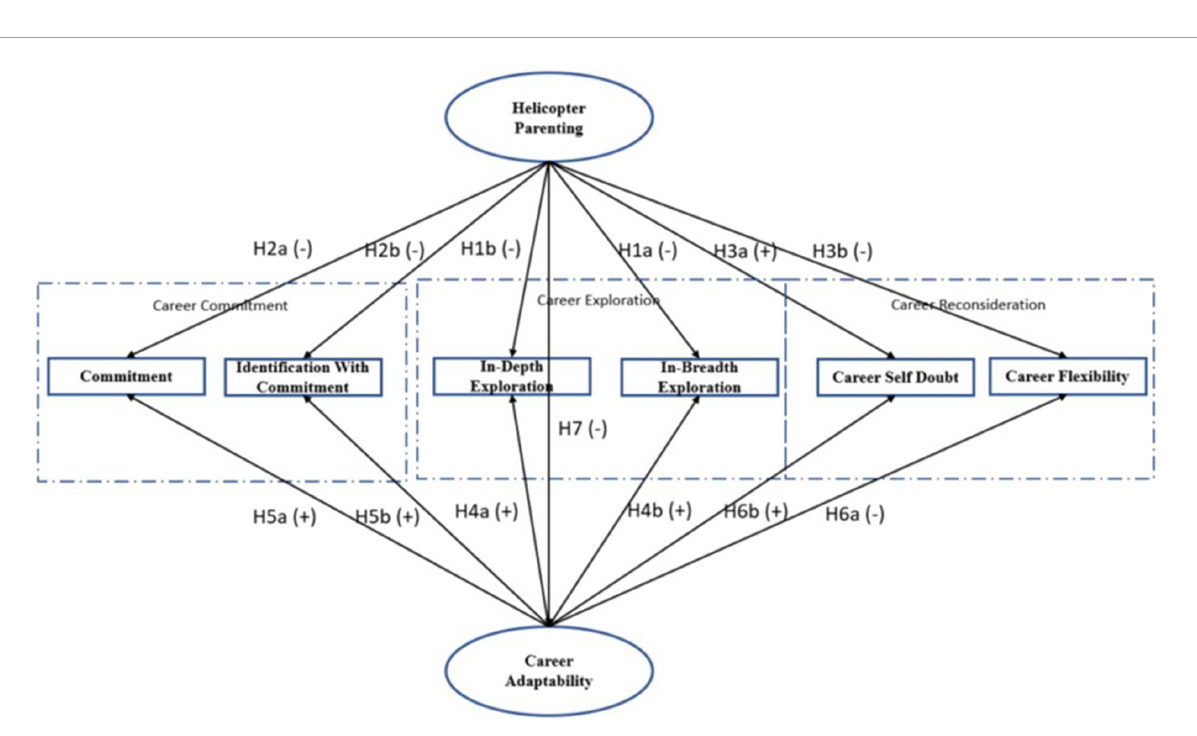
FIGURE1 Conceptual model of hypothesized relationships between study